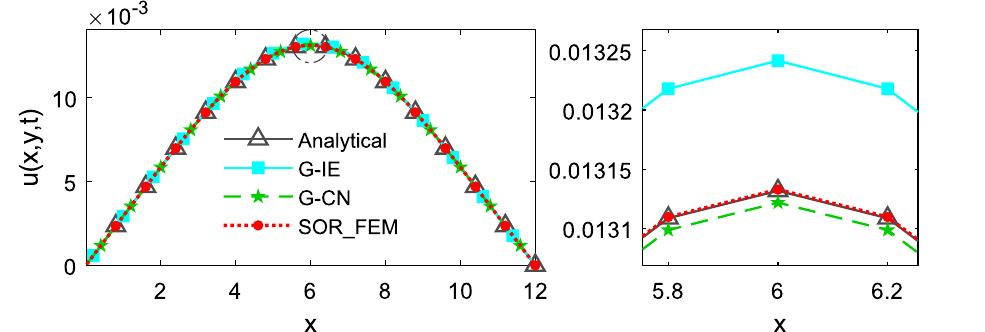
Figure 5. Temperature along the x-axis at time t = 1.2.